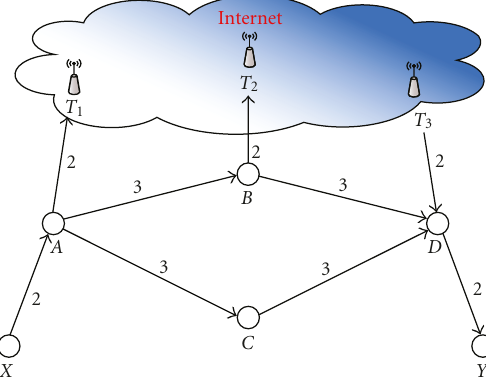
Figure 2: Simple example of hybrid wireless